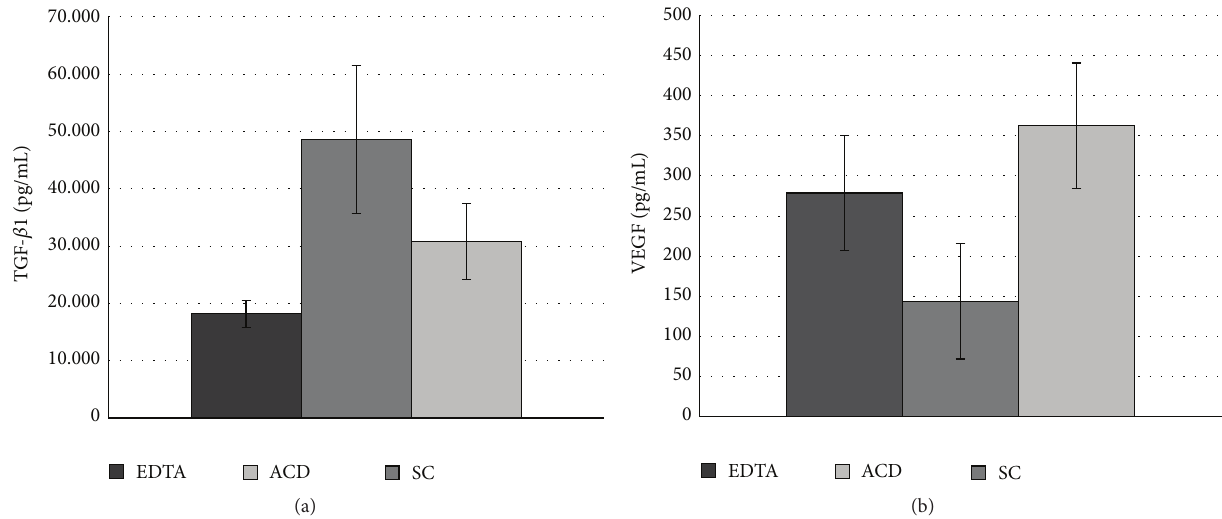
Figure 3: Growth factor quantification in PRPr obtained in different anticoagulant. TGF- 𝛽 1 (a) and VEGF quantification (b). Data are expressed as mean, and error bars correspond to standard